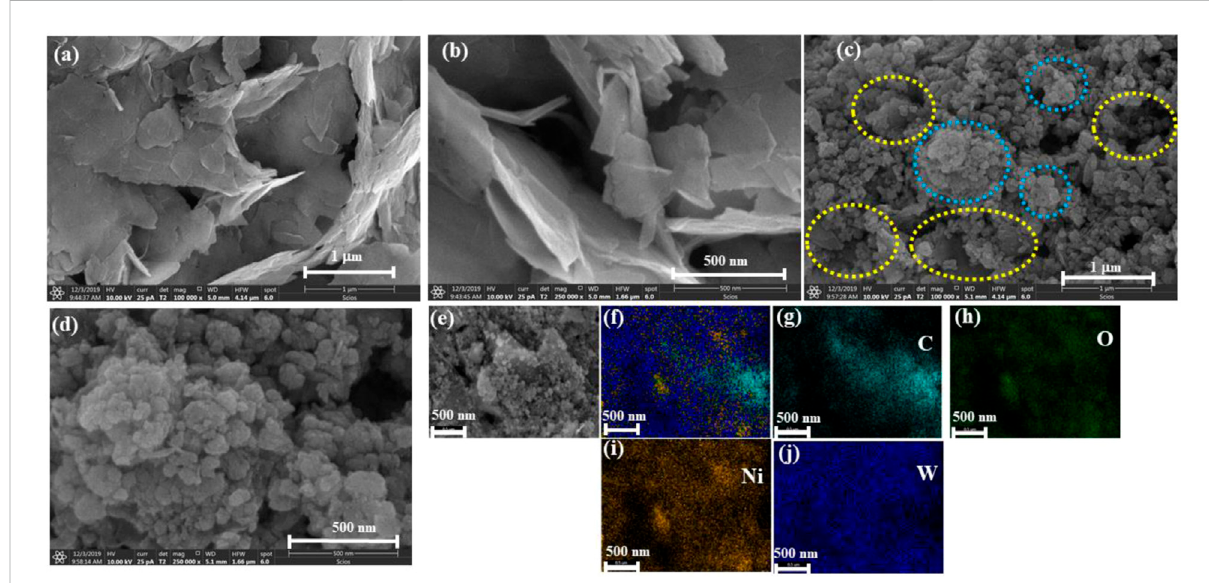
FIGURE 2 (A , B) SEM images of Ni-Gr composites. Wrinkled, aggregated graphene sheets are present (C , D) SEM images of WO 3 -Ni-Gr composites. A bumpysurfaceapproximatingthewalnut-likesurfacecon fi